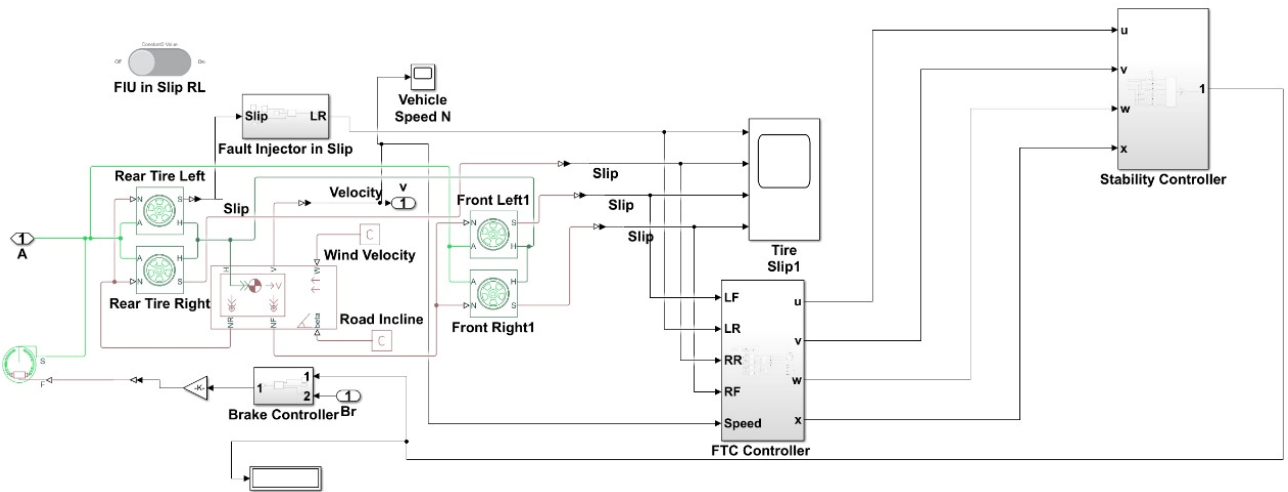
Figure 3. Tire Slip Calculation Model.